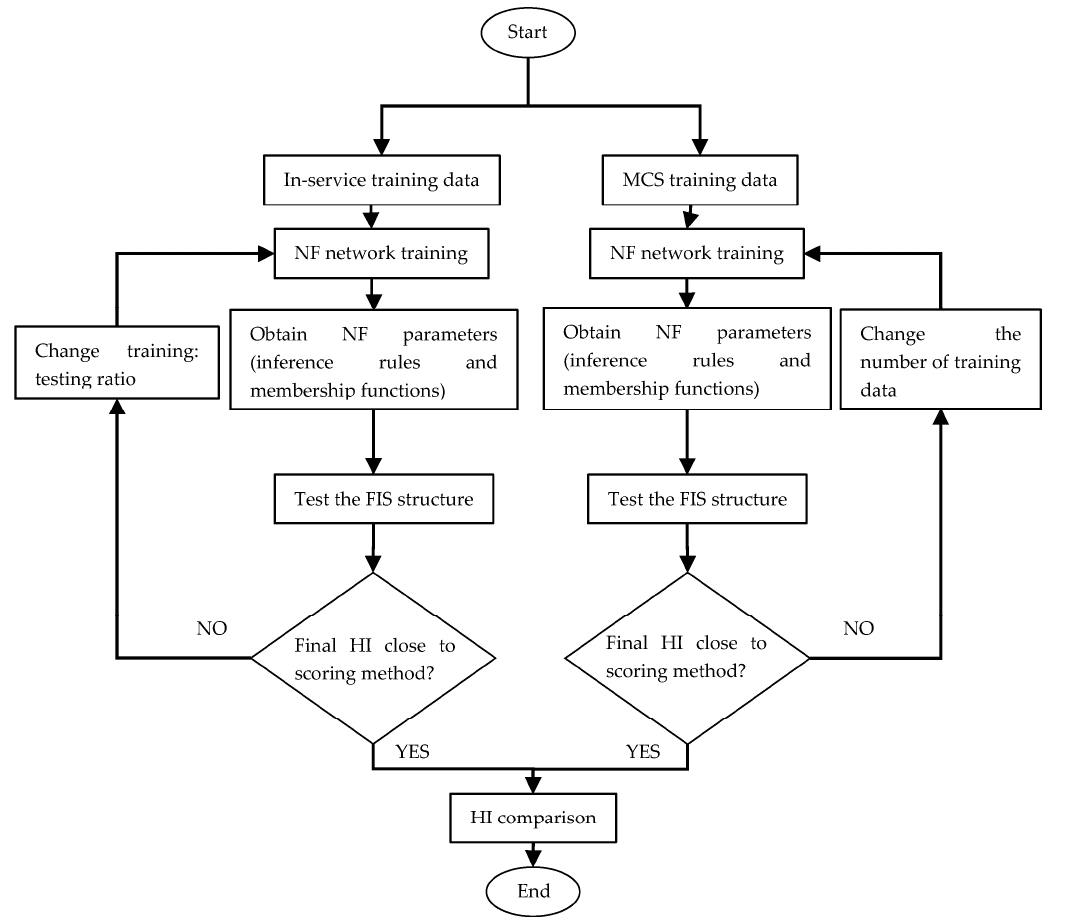
Figure 3. Flowchart for training the NF network. MCS: Monte Carlo Simulation.